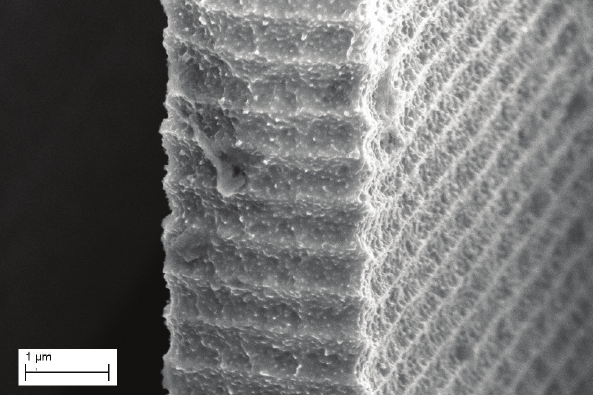
Figure 4. Scalloping details in one finger.